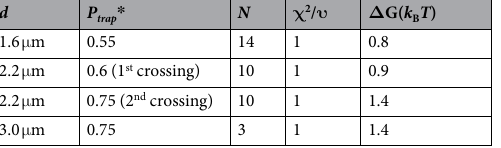
Table 1. P trap * values obtained from the Viterbi iteration for the best fits with g and w trap . N is the number of trapped steps during the observation